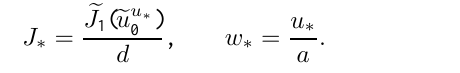
(cid:15) Calculate the quantity w (cid:15) Find the corresponding value J curve of Fig. 3. (cid:15) Calculate the quantity e J The trade-off curve of Fig. 3 can be used also for solving the problem which is dual to Problem 3, i.e.,